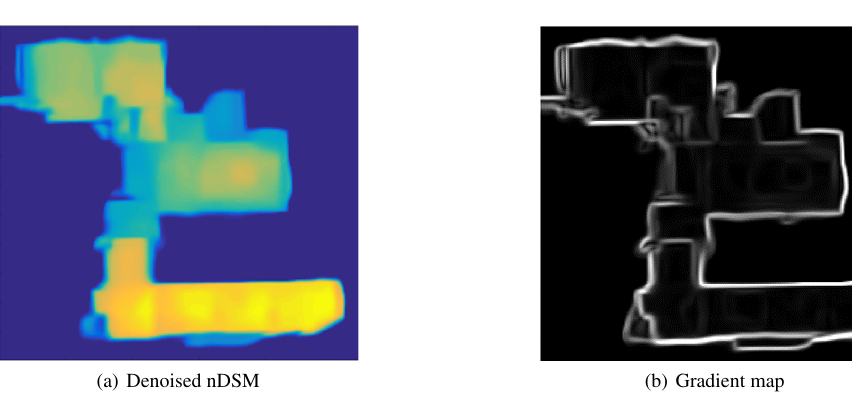
Figure 2: Example of denoised nDSM and its gradient